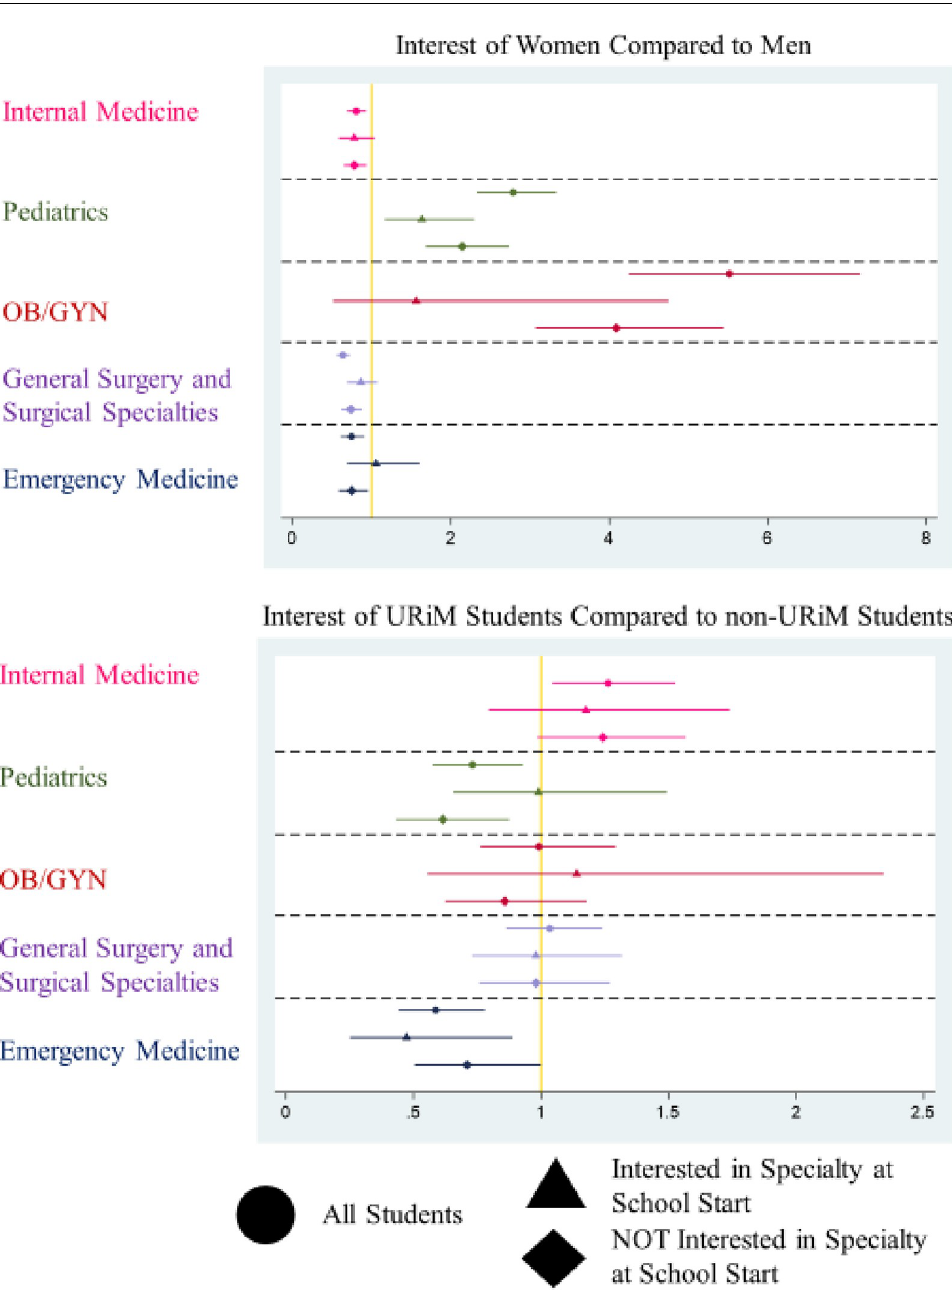
Fig 2. Graduating interest comparison. Plot of Odds Ratios from Three Approaches (All Students regardless of entering interest, Only Students Initially Interested in the specialty at the beginning of Medical School, and Only Students NOT Initially Interested in the specialty at the beginning of Medical School) on a logarithmic scale. X-Axis represents the Odds Ratio of the Outcome in each model for each group. Gold line represents Odds of 1 (no effect). Y-Axis represents the medical specialties investigated. Each point represents the calculated Odds Ratio with the 95% Confidence Interval for each value represented by bars to either side.